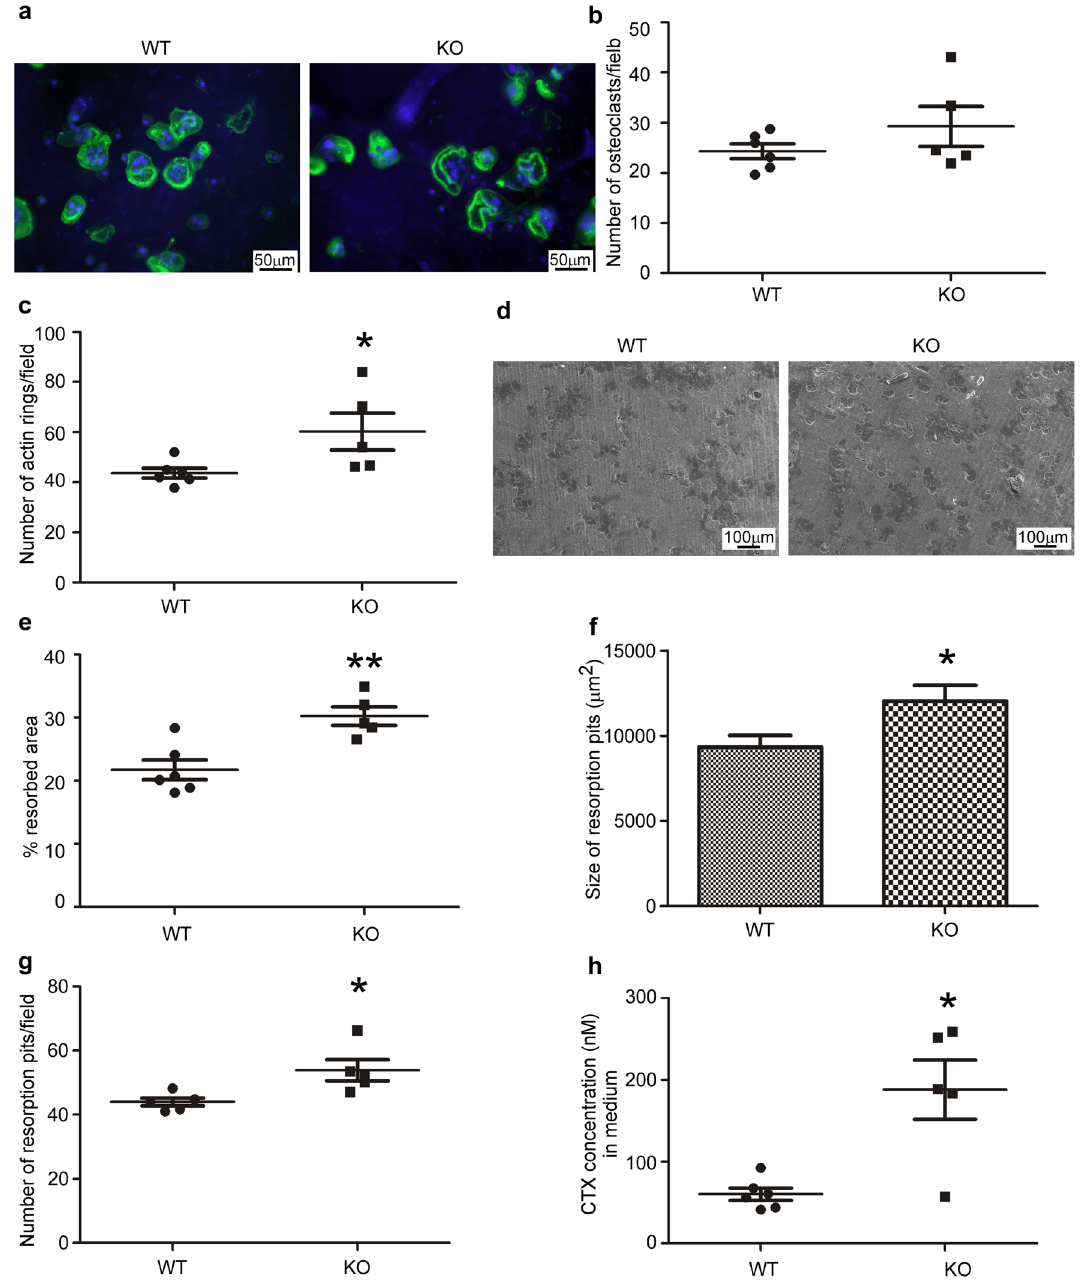
Figure 2. Inactivation of HYAL1 increases the resorption activity of osteoclasts. ( a ) After 10 days of differentiation on bovine bone slices, WT or Hyal1 −/− osteoclasts were fixed with paraformaldehyde. Actin rings and nuclei were then stained with Alexa 488-phalloidin (green) and Hoechst 33258 (blue), respectively. ( b ) The number of polarized osteoclasts was quantified on 2 bone slices for each mouse (with n ≥ 5 mice in each group and min 5 images per bone slices). The graph shows mean numbers of osteoclasts per field ± SEM. ( c ) The same images were used to compare the number of actin rings between WT and Hyal1 −/− conditions. Results are expressed as mean numbers per field ± SEM. ( d ) After removal of the osteoclasts, the resorption pits were observed by scanning electron microscopy. ( e , f ) Quantifications of the percentage of the resorbed area ( e ) and of the number of resorption pits per field ( f ) were conducted based on 10 images per bone slice (with 2 bone slices for each mouse and n = 5 mice per genotype). ( g ) The average size of resorption pits was assessed from the measurement of at least 60 pits for each mouse (n = 5 mice per group). ( h ) CTX released from the bovine bone slices upon resorption by osteoclasts were measured in the culture supernatants using an ELISA assay. To do so, conditioned media were collected between day 8 and day 10 after plating and differentiation of the macrophages on bone slices (n ≥ 5 mice per group, and technical replicates were quantified). The graphs show the means ± SEM. *p < 0.05, **p < 0.01 (two-tailed Mann–Whitney U